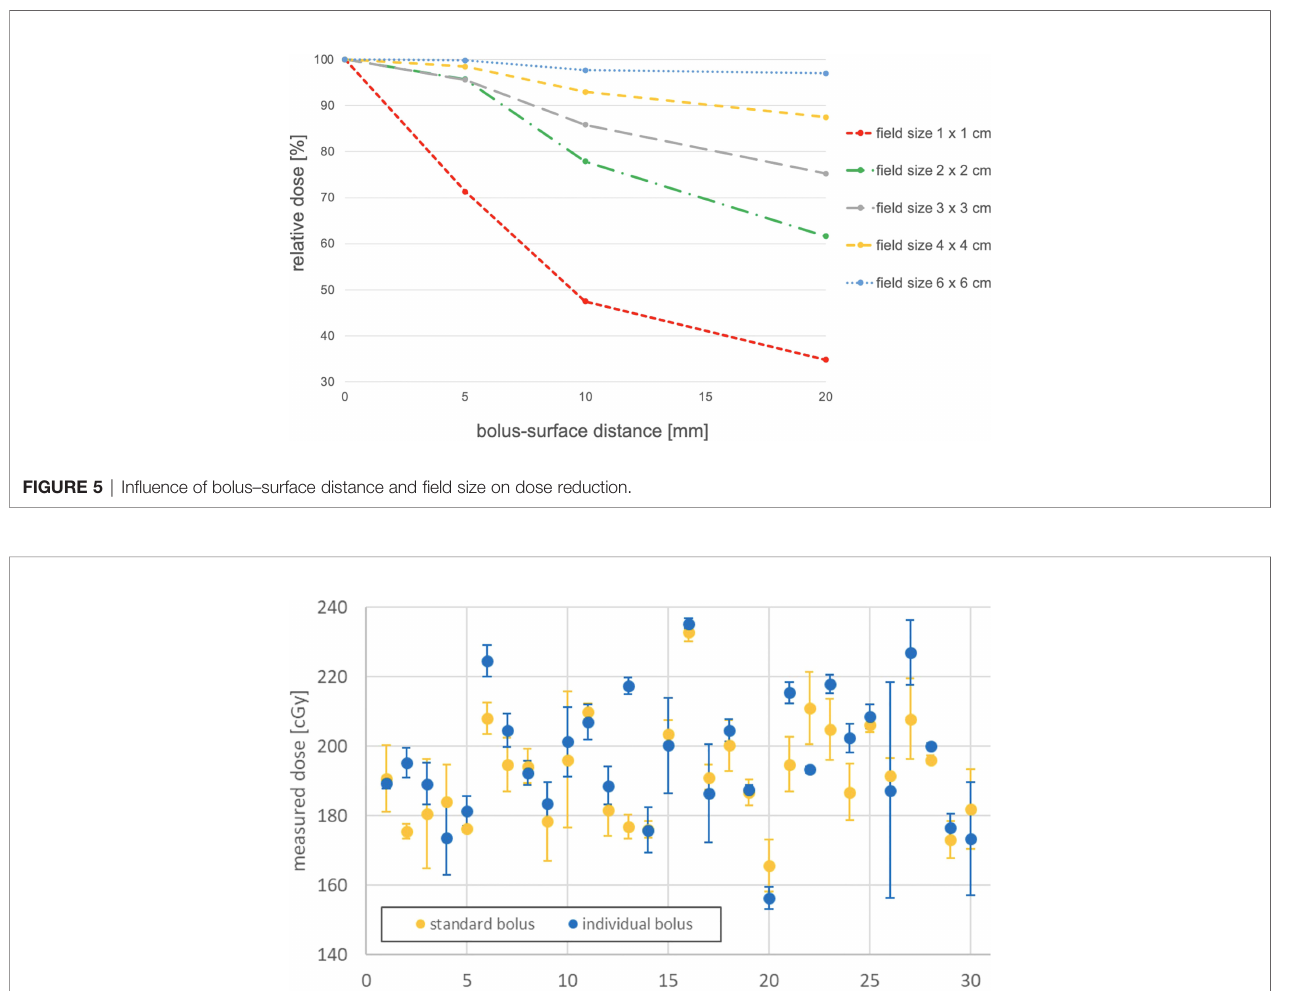
FIGURE 6 | Surface dose under standard and individual boluses.